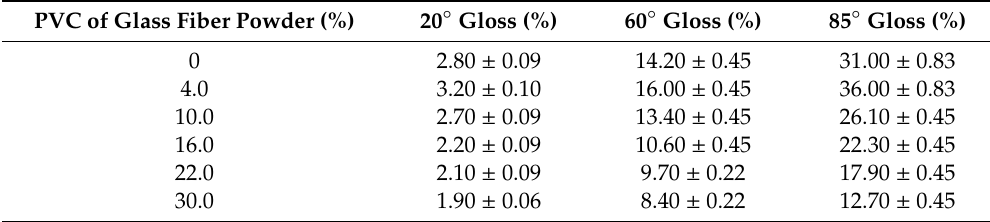
Table 3. Influence of PVC of glass fiber powder on gloss of thermochromic waterborne coating.